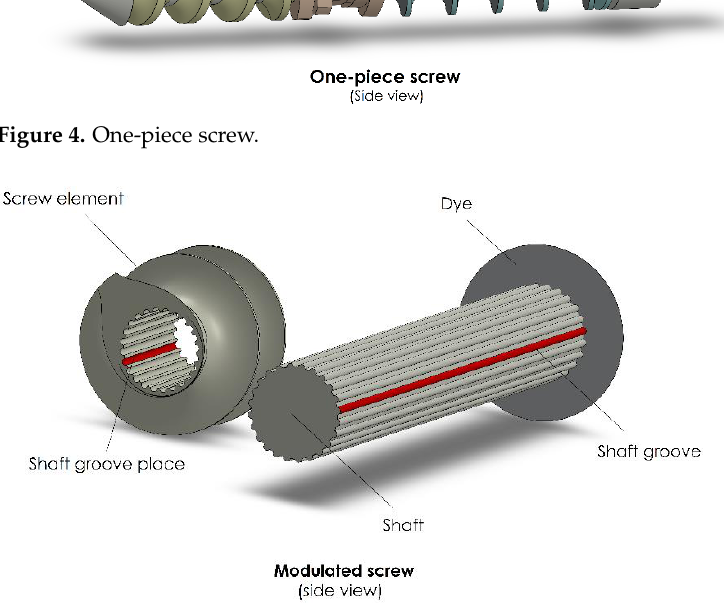
Figure 5. Modulated screw.